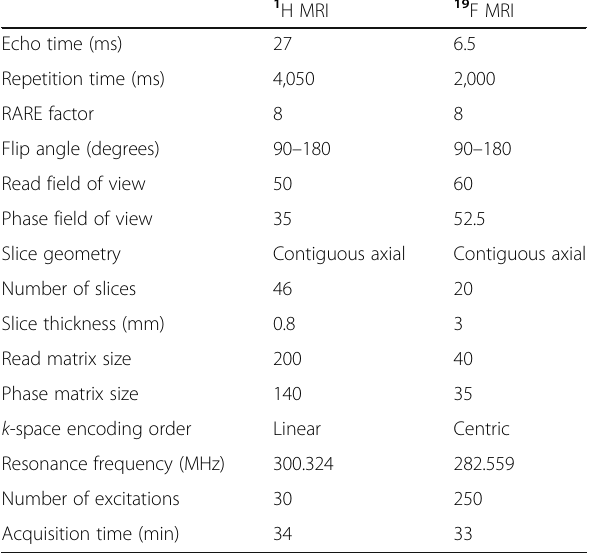
Table 1 Acquisition parameters of 1 H and 19 F sequences